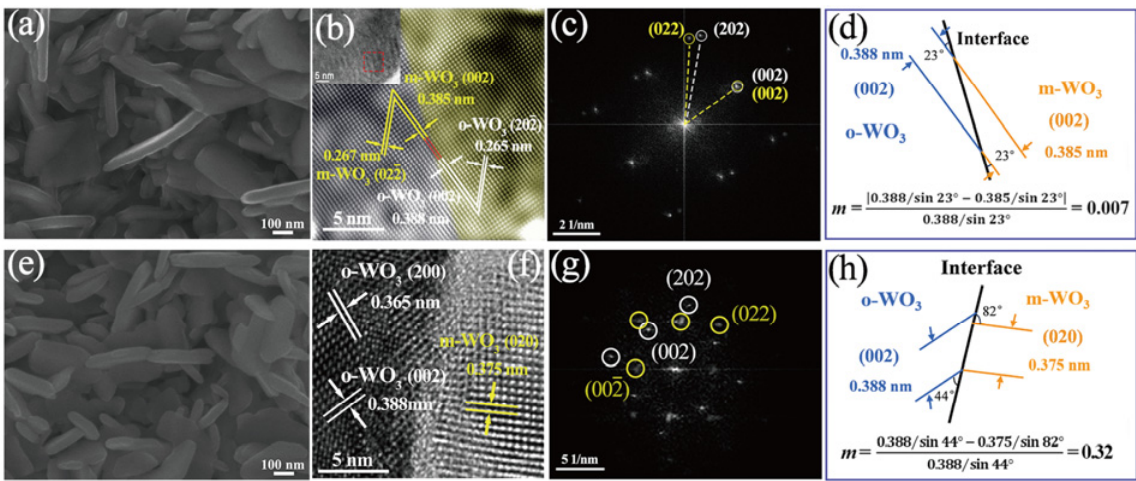
Fig. 4 Morphologies and microstructures of the as-prepared samples: (a, e) SEM images, (b, f) HRTEM images, (c, g) FFT patterns of (b) and (f), respectively; and schematics of the o-WO 3 /m-WO 3 phase interface for (d) WO 3 -450 and (h) WO 3